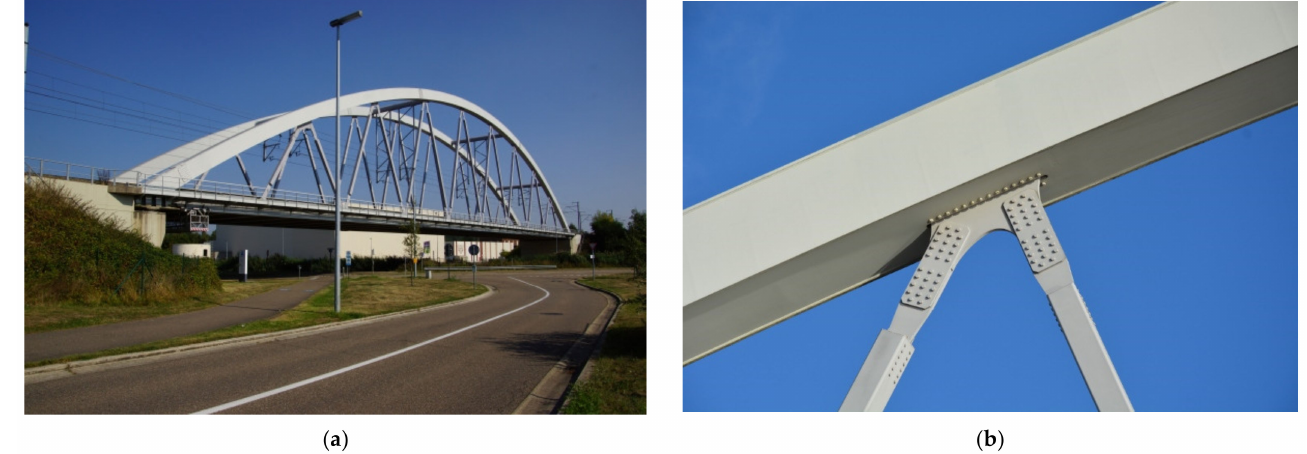
Figure 3. ( a ) The KW51 bridge in Leuven and ( b ) Example of bolted connection between a brace and the arch of the bridge (Reprinted from ref. [54]).